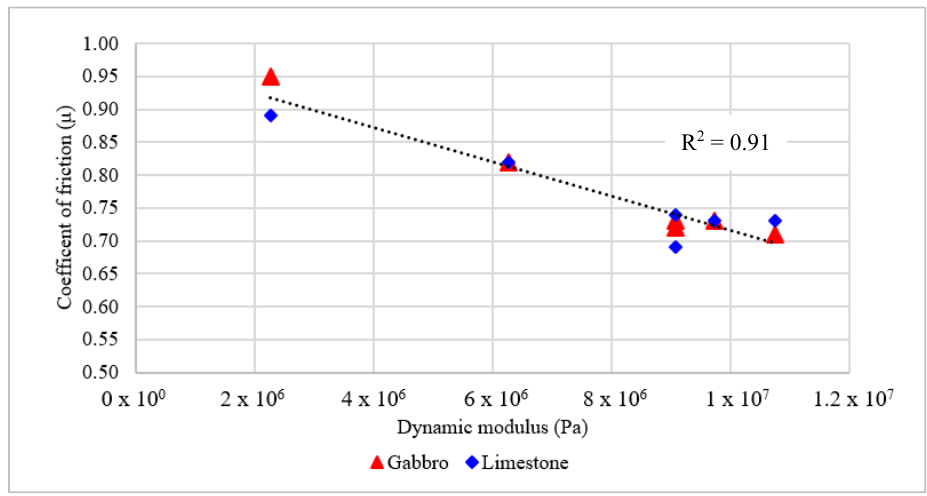
Figure 11 . Relationship between the rubber dynamic modulus and the coefficient of friction. Figure 11. Relationship between the rubber dynamic modulus and the coefficient of